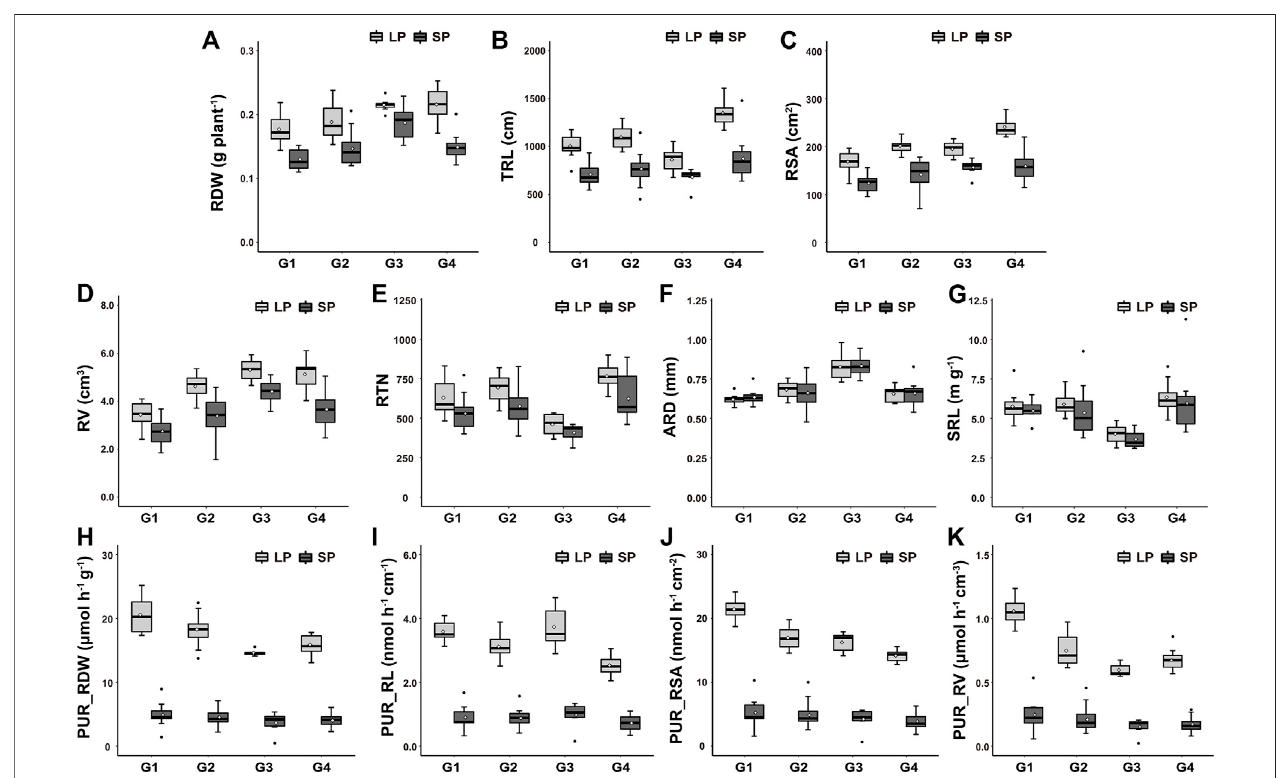
FIGURE 7 | Box and whisker plot showing differences in 11 traits among high-P uptake capacity peanut germplasms under low-P (LP) and suf fi cient-P (SP) treatments. (A) Root dry weight per plant(RDW), (B) total tootlength(TRL), (C) rootsurface area(RSA), (D) rootvolume (RV), (E) roottip number (RTN), (F) average root diameter(ARD), (G) speci fi crootlength(SRL), (H) Puptakerateperunitrootdryweight(PUR_RDW), (I) Puptakerateperunitrootlength(PUR_RL), (J) Puptakerateper unitrootsurfacearea(PUR_RSA),and (K) Puptakerateperunitrootvolume(PUR_RV).High,moderate,andlowrepresenthigh,moderate,andlowPuptakerates per plant, respectively. Horizontal lines inside boxes, median; white dot, mean; box hinges, fi rst and third quartiles; whiskers, full range of the data; black dots represent outliers.